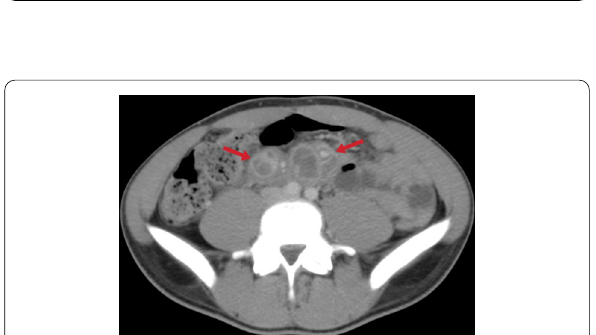
Fig. 24 A 19-year-old male. Post-contrast CT image shows multiple mesenteric lymphadenopathies with peripheral